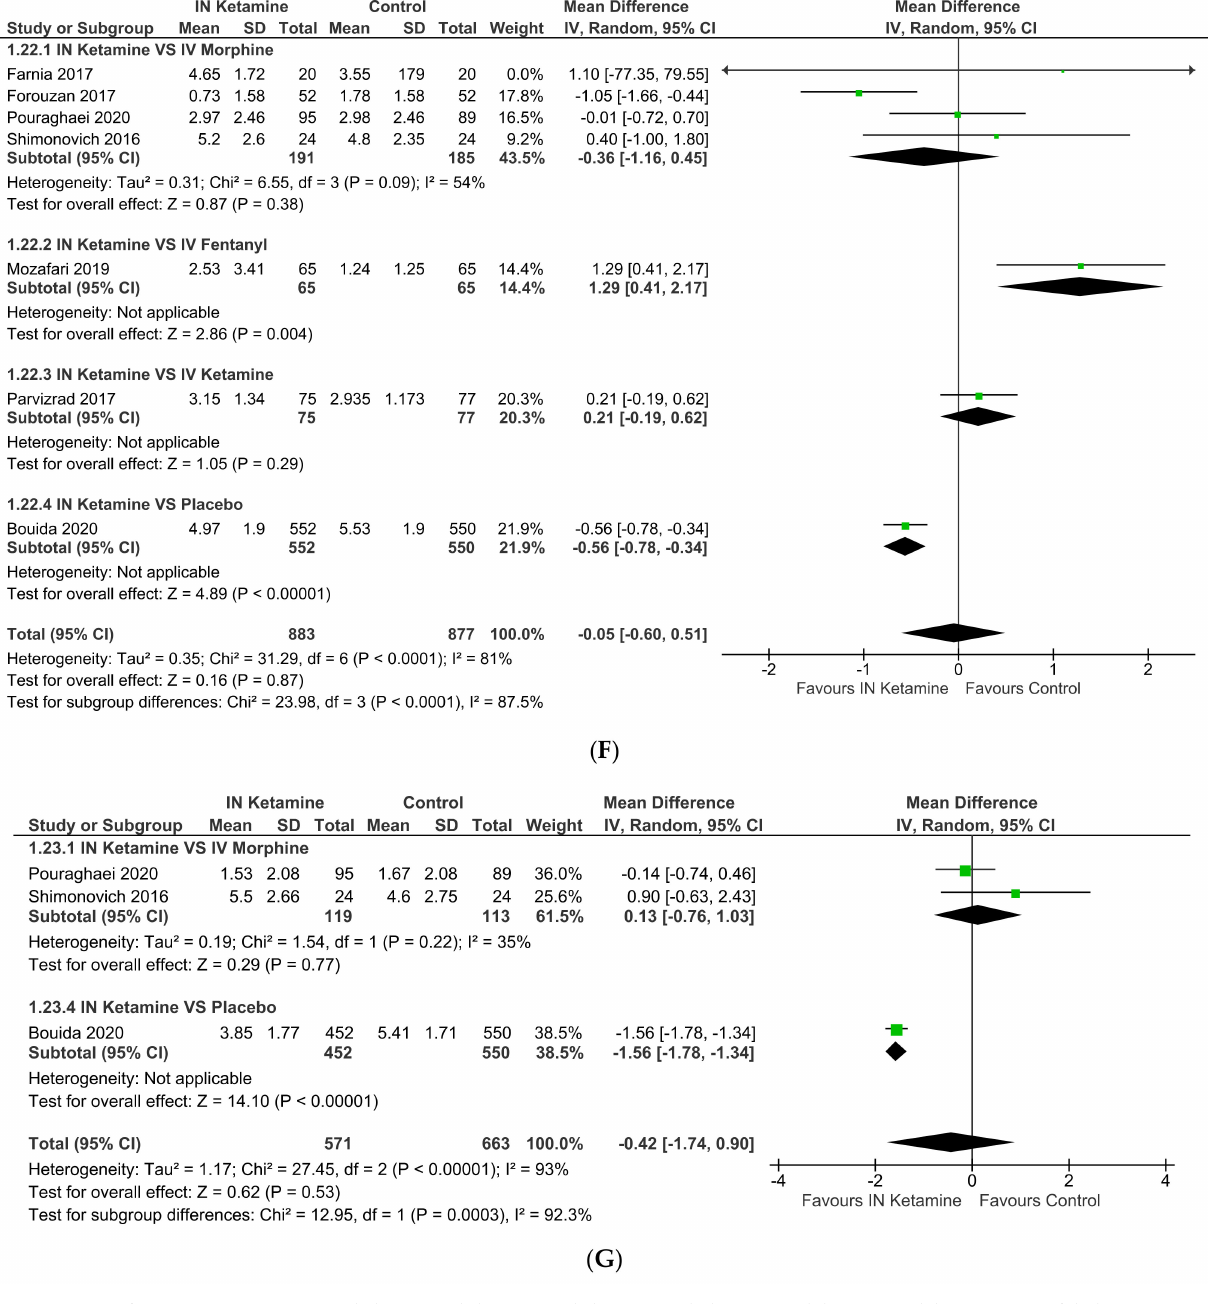
Figure 2. Change in pain score at ( A ) 5 min, ( B ) 10 min, ( C ) 15 min, ( D ) 20 min, ( E ) 25 min, ( F ) 30 min, and ( G ) 60